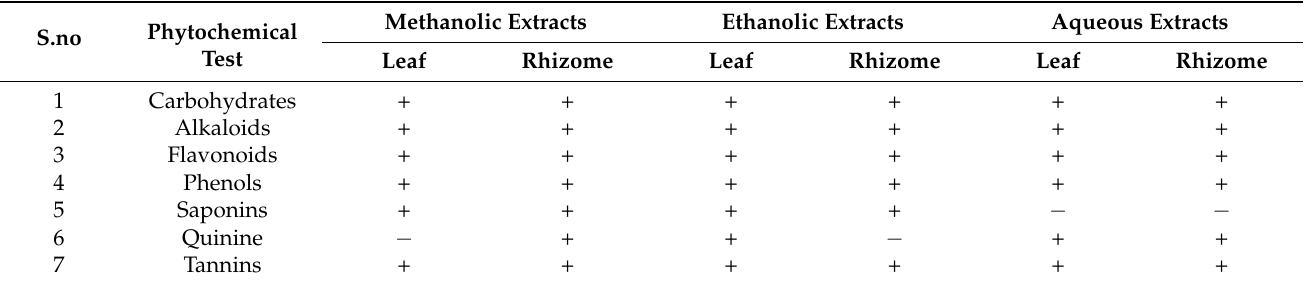
Table 5. Qualitative detection of bioactive compounds of P. lonchitis leaves and rhizomes.